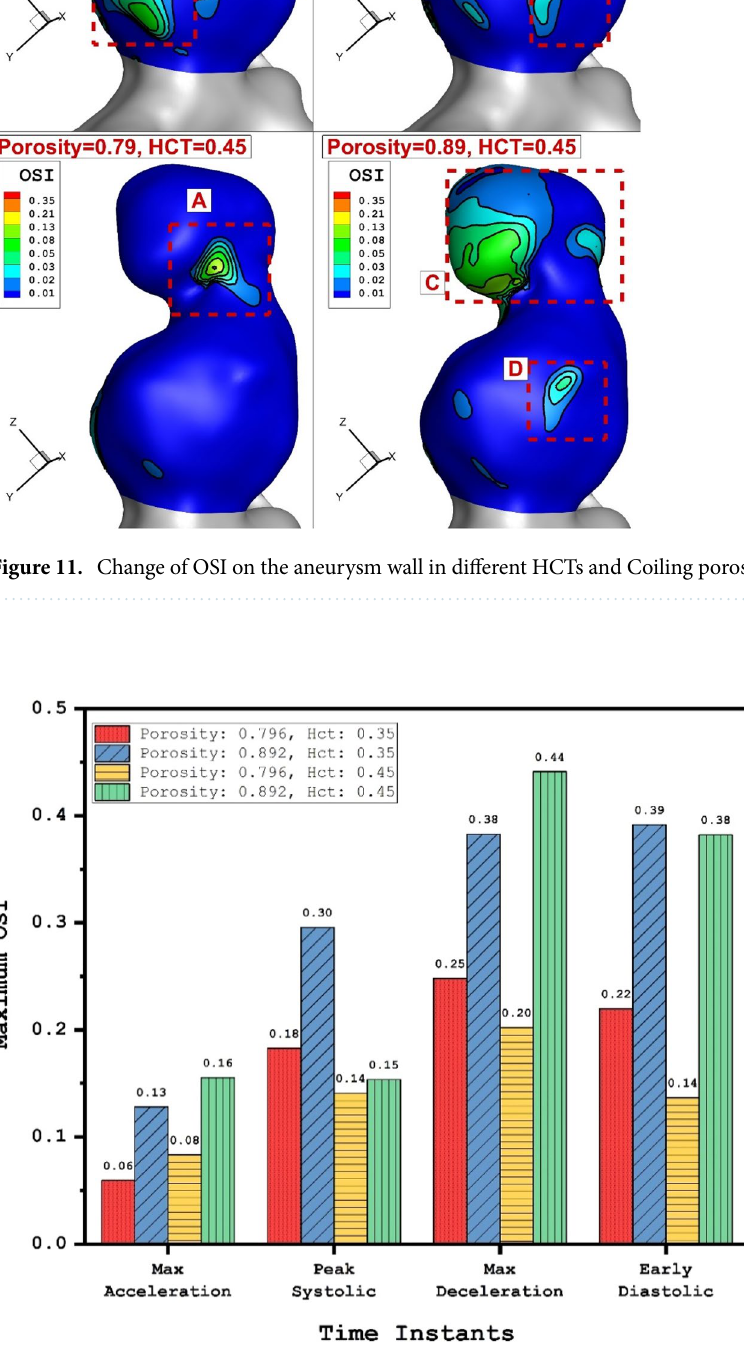
Figure 12. Comparison of Maximum OSI on the aneurysm wall in different HCTs and Coiling